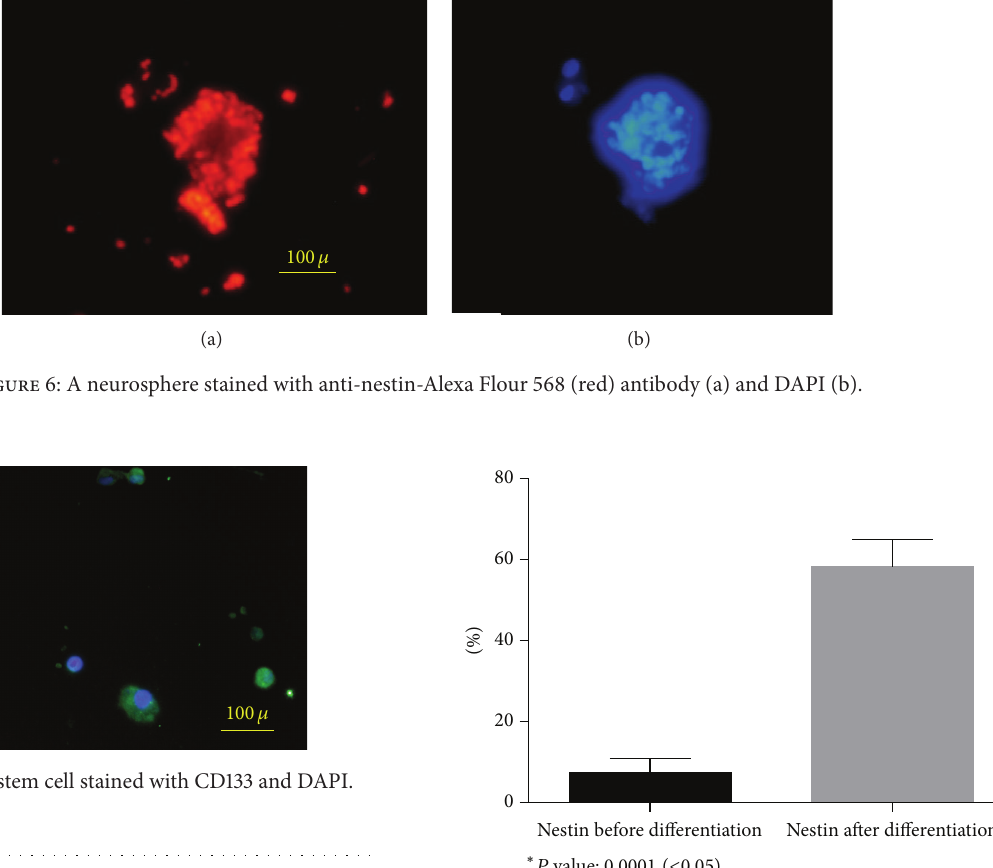
Nestin before differentiation Nestin after differentiation